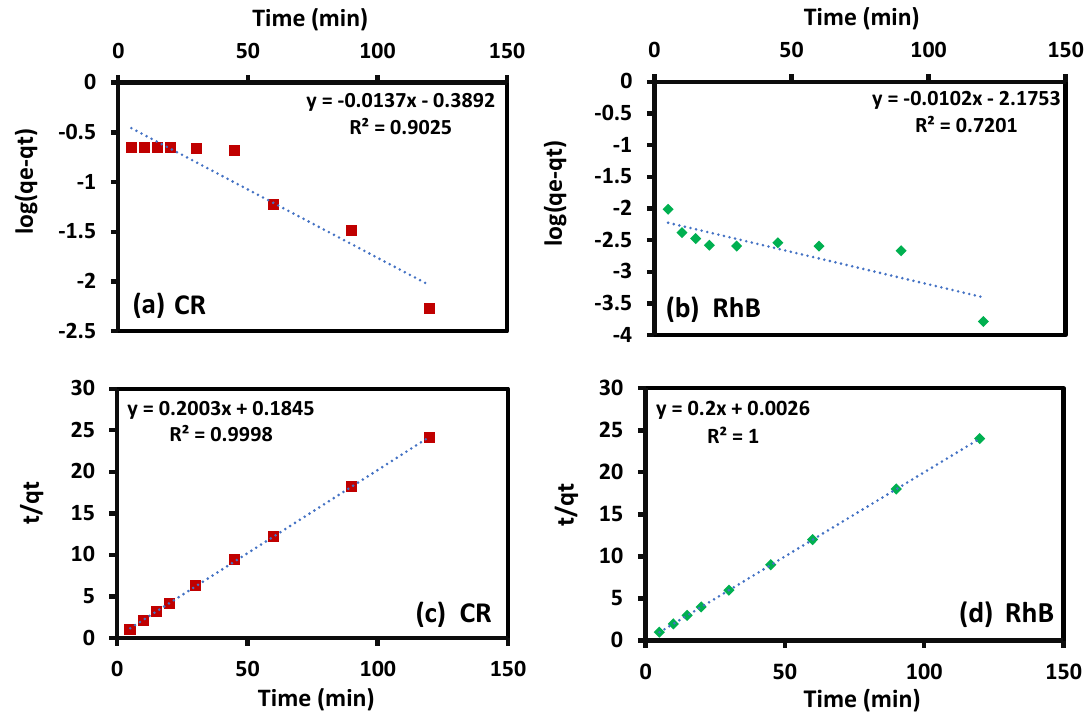
Figure 9. Adsorption kinetics: pseudo-first-order model of ( a ) CR dye; ( b ) RhB dye and pseudo-second-order model for the adsorption of ( c ) CR dye; ( d ) RhB dye by PTFAC (reaction conditions: T= 298 K, pH = 2.0, C o = 25 mg L −1 , mass = 0.15 g, V = 20 mL).